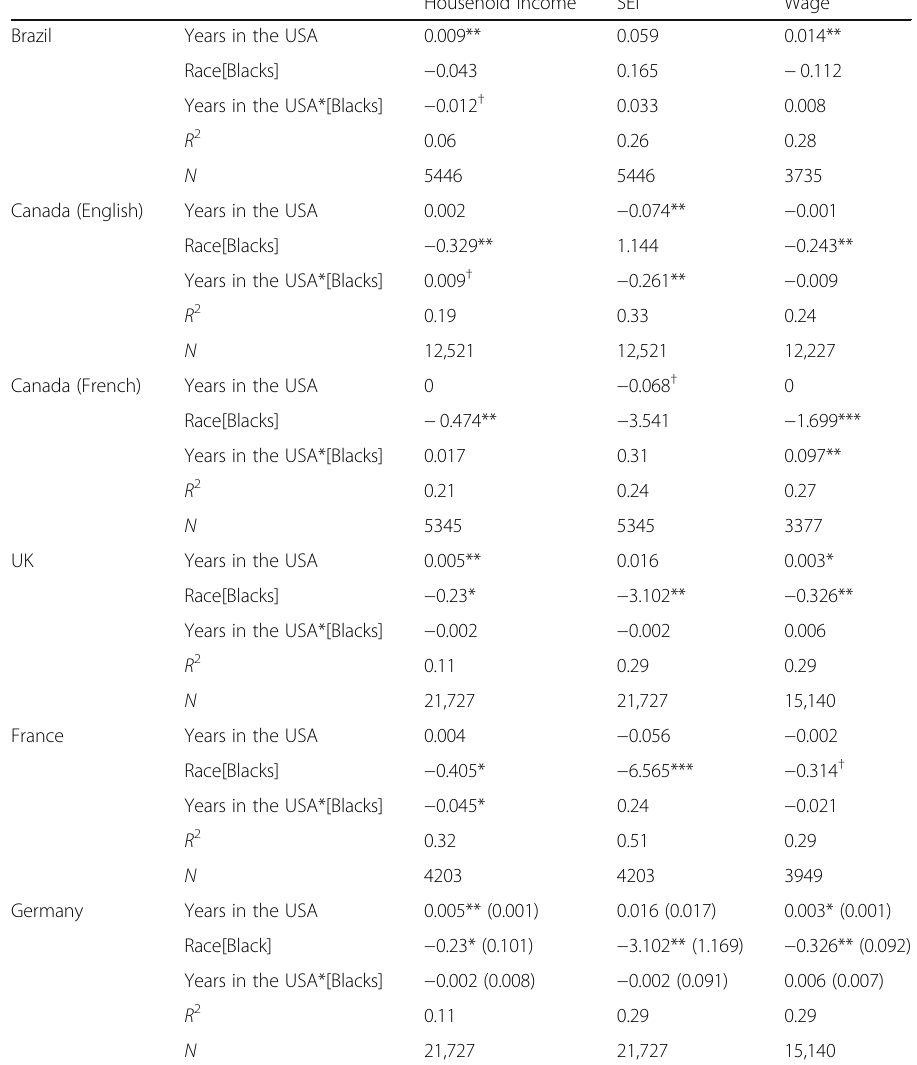
Table 4 OLS regressions of economic characteristics for immigrants to the USA, age 25 to 64, interaction of race with years in the USA